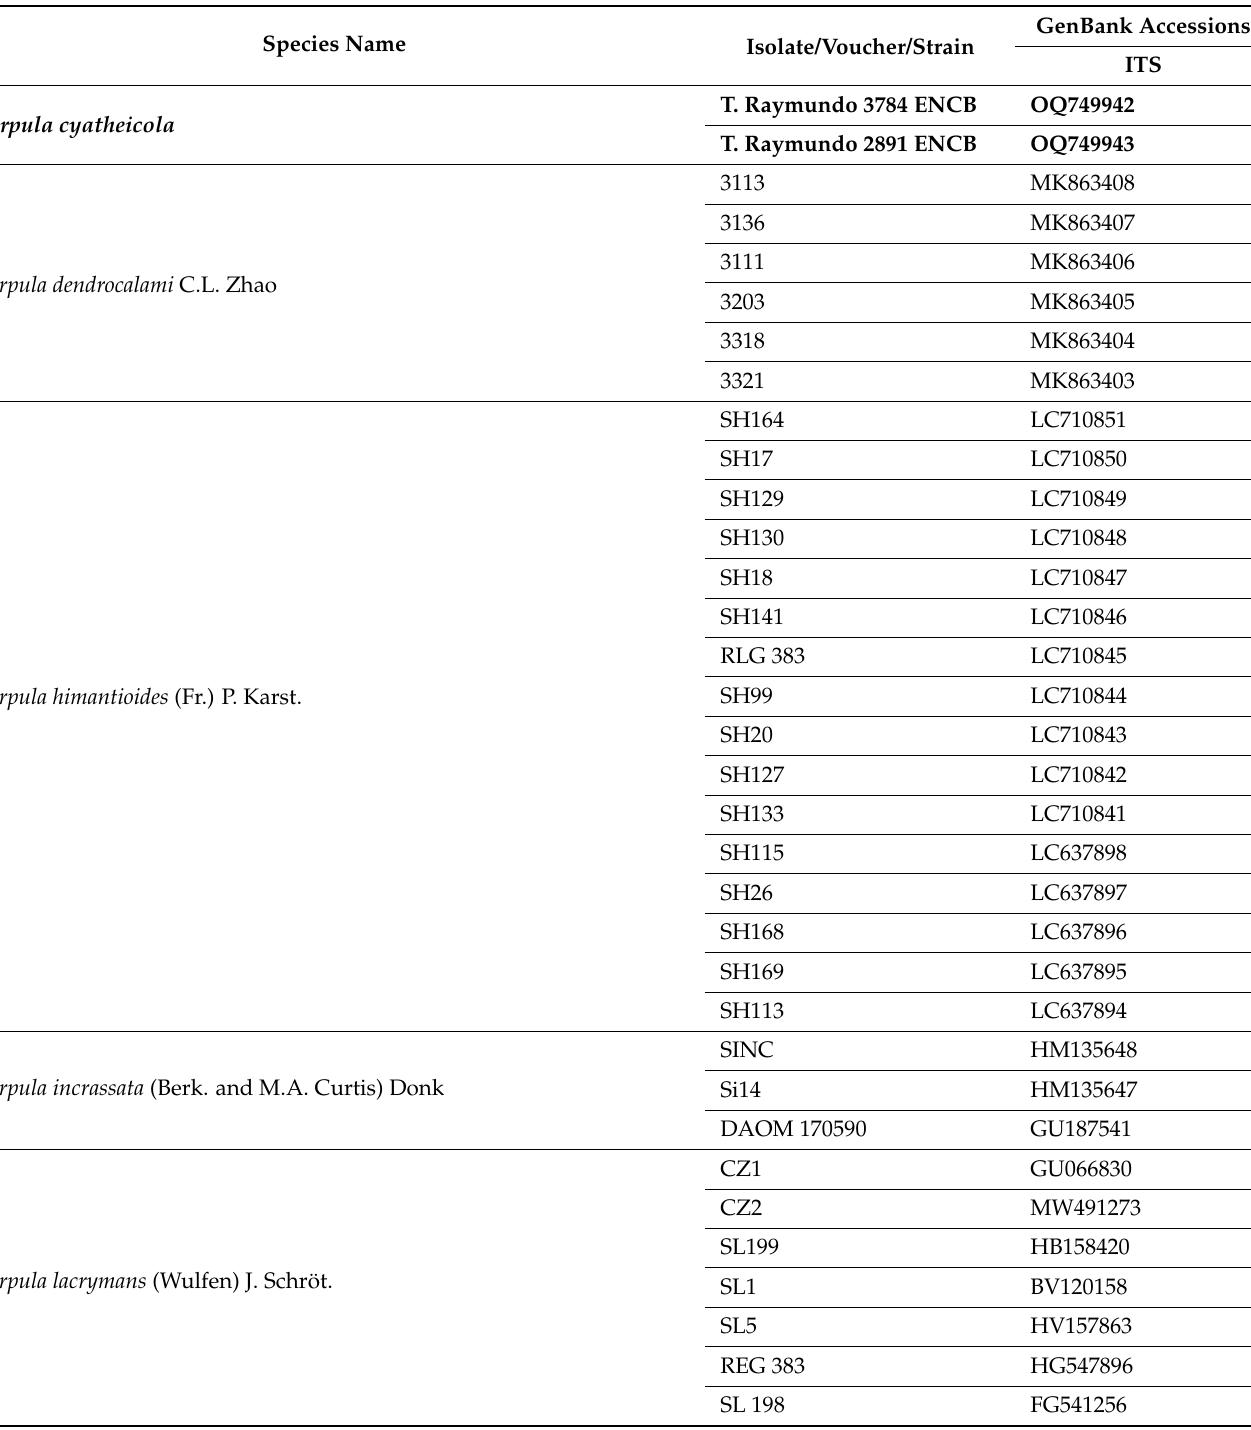
Table 3. GenbBank accession numbers corresponding to the Serpula sequences used in the phyloge- netic analyses. In bold, the accessions of the new